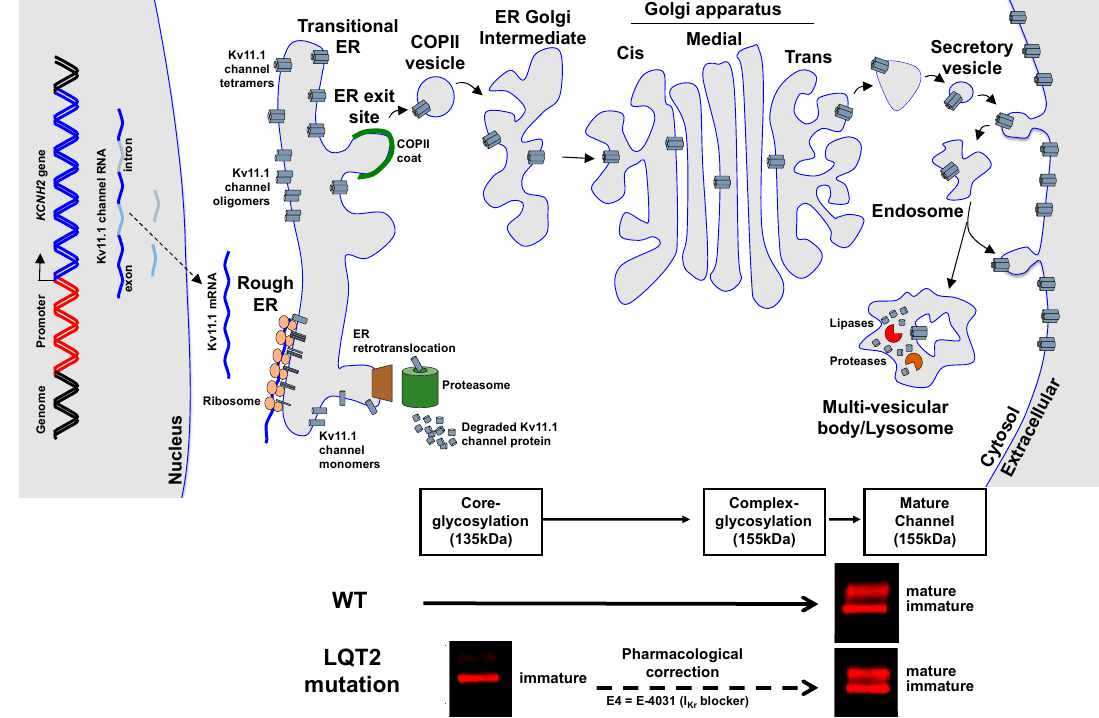
Figure 3. A cartoon diagram of the Kv11.1 channel tra ffi cking pathway. KCNH2 is transcribed and spliced to mRNA, which is then translated in the ER as a core glycosylated Kv11.1a α -subunit with a molecular mass of 135 kDa. It undergoes terminal glycosylation as it tra ffi cs through the Golgi apparatus and its molecular weight increases to 155 kDa. Kv11.1 channels recycle on and o ff the membrane in endosomes every few minutes for several hours before being degraded in the lysosome pathway. Representative Western blots of cells expressing WT-Kv11.1a α -subunit or a Class 2 LQT2 channel protein are shown below the cartoon. In control conditions, the immunoblot of cells expressing WT-Kv11.1a contains both core and terminally glycosylated Kv11.1a protein bands, whereas cells expressing the Class 2 LQT2 mutant channel protein show only the core glycosylated form. Incubating cells in I Kr blockers (e.g., E-4031) increases terminal glycosylation and functional expression of Class 2 LQT2 channel proteins (pharmacological correction, dashed